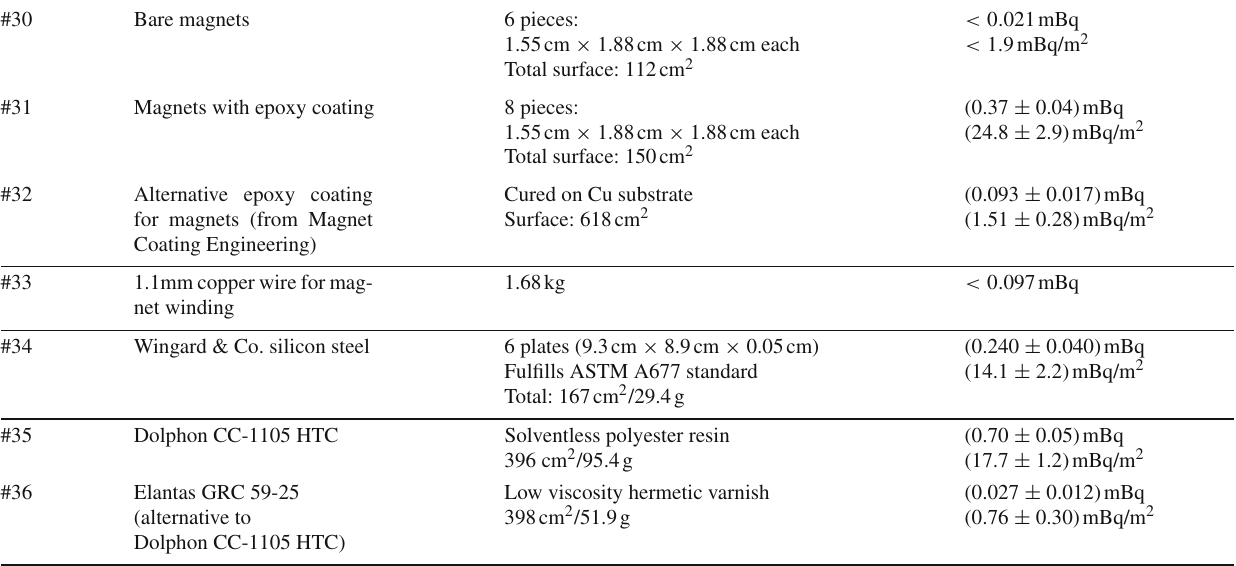
Table 6 Results of 222 Rn emanation measurement to identify and replace the dominant 222 Rn sources in the QDrive